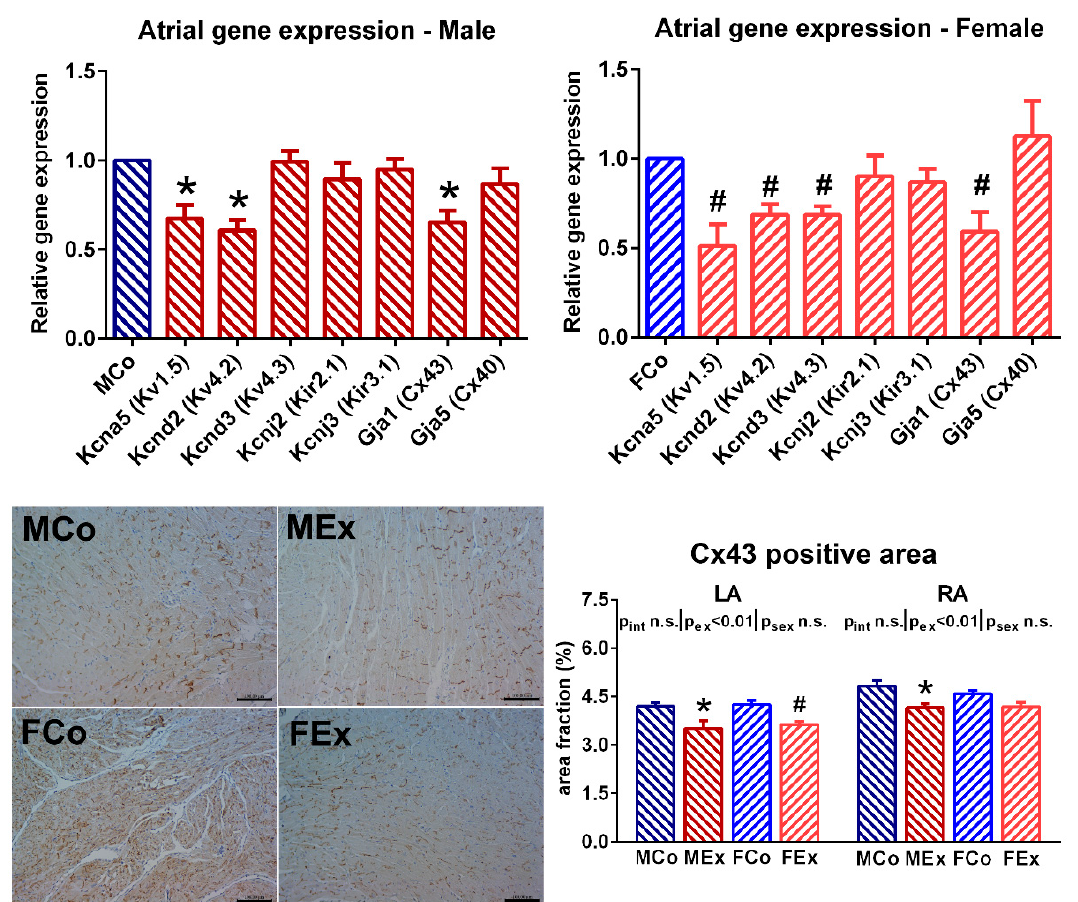
Figure 5. Upper panel Right atrial gene expression of different voltage-gated potassium channels (Kv1.5, Kv4.2, and Kv4.3), inward rectifier potassium channels (Kir2.1 and Kir3.1), and connexins (Cx40 and Cx43) in male and female animals. Relative gene expression values of exercised rats were compared to male control (MCo) and female control (FCo) animals. Lower panel Representative left atrial Cx43 immunostained sections (magnification 200 × , marker 100 µ m) from one–one MCo, male exercised (MEx), FCo, and female exercised (FEx) animals a Cx43 density data from the left (LA) and right (RA) atrium. Values are means ± SEM. * p < 0.05 vs. MCo, # p < 0.05 vs. FCo. p ex and p sex : p -value of two-way analysis of variance (ANOVA) factors exercise and sex, respectively; p int : interaction p -value of two-way ANOVA.